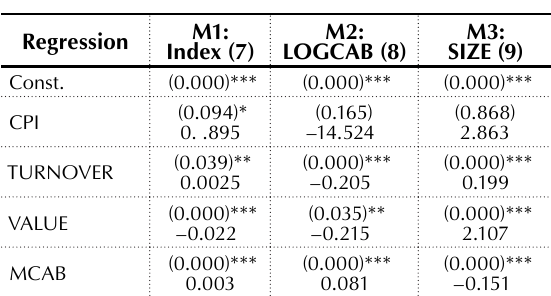
(three columns of MCO